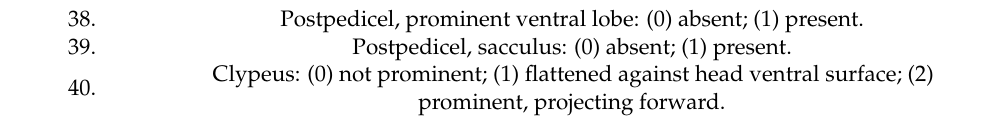
Table 1. Characters added to the morphological dataset of Li and Yeates [8] for the phylogenetic analysis.